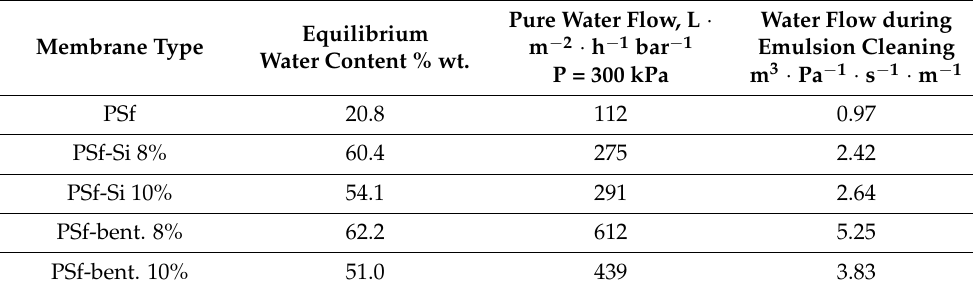
Table 2. Comparison of the properties of PSf membranes modified with silicon (Si) and bentonite (bent.) [70].